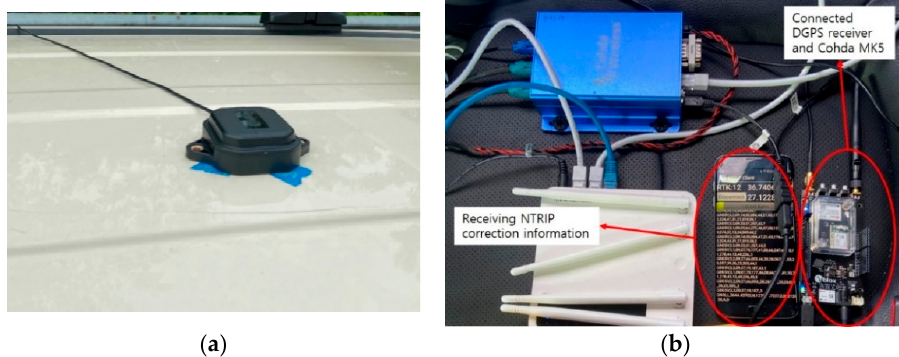
Figure 12. ( a ) DGPS antenna mounted in the center of the vehicle; ( b ) environment inside the vehicle.